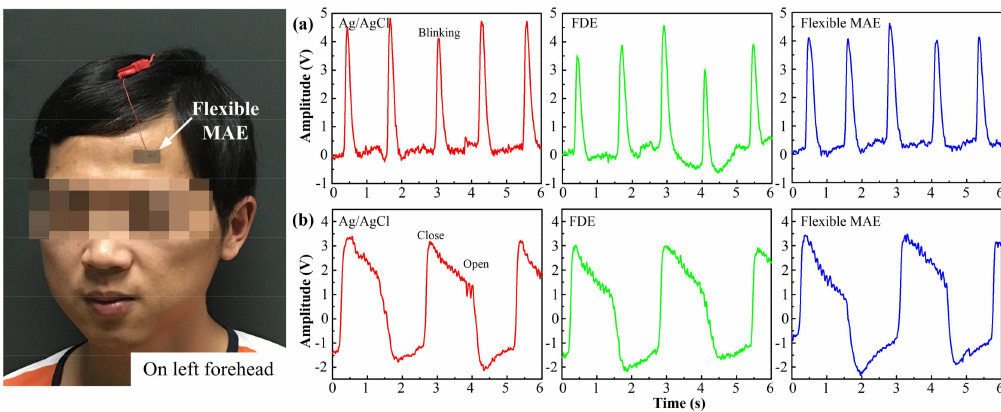
Figure 7. EEG signals recorded by the Ag/AgCl electrode, FDE and flexible MAE under: ( a ) the eyes blinking, and ( b ) the open and closed eyes